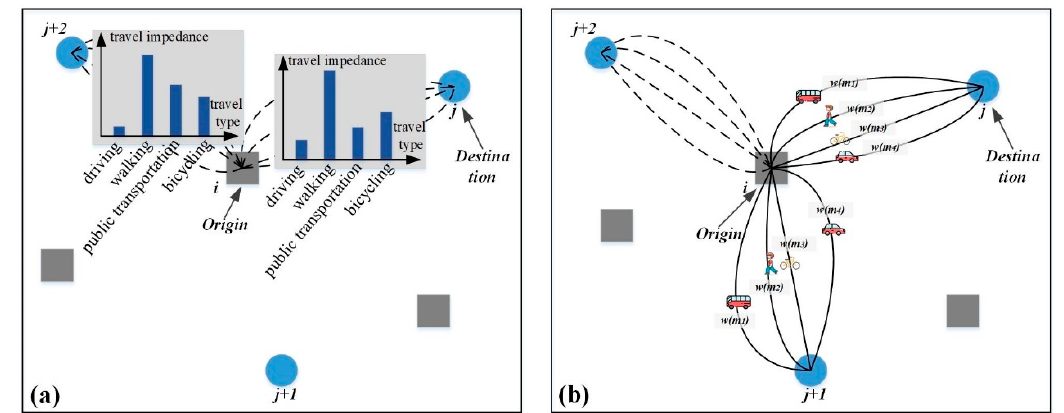
Figure 1. Schematic diagram of multiple transportation modes-residential transportation mode choices (MTM-RTMC). The RTMC probabilities, which mainly depend on di ff erent transportation modes’ travel impedance (Figure 1a), illustrate that di ff erent transportation modes from an origin location i (demand location) to destination location j (supply location) have di ff erent probabilities w ( m i ) of being chosen (Figure 1b).